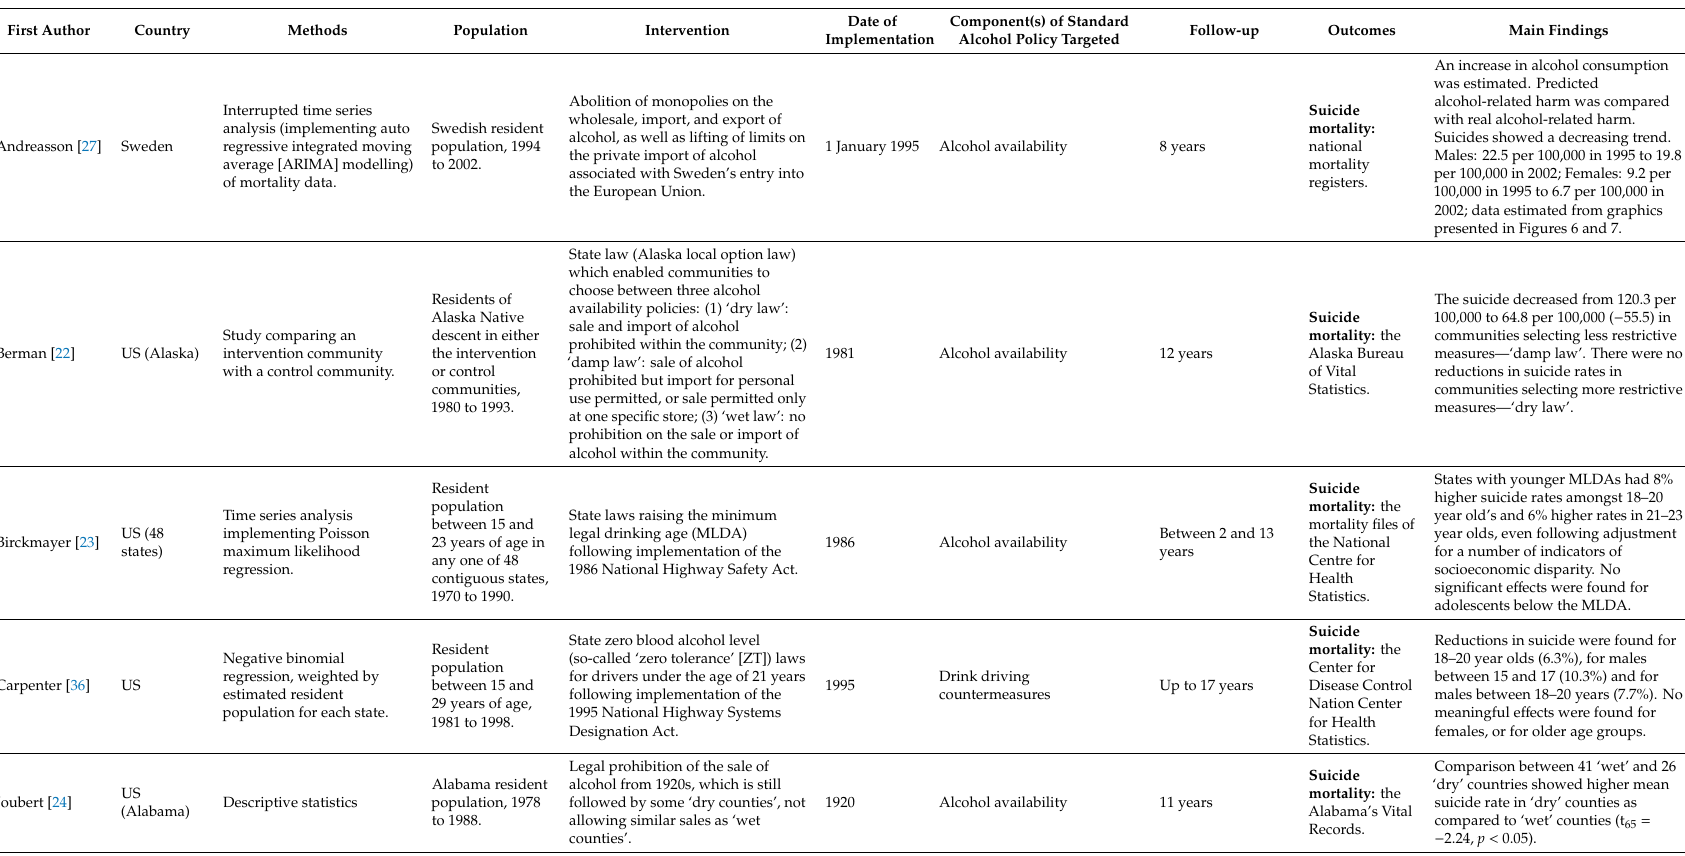
Table 2. Methodological characteristics and main findings of the ecological-level